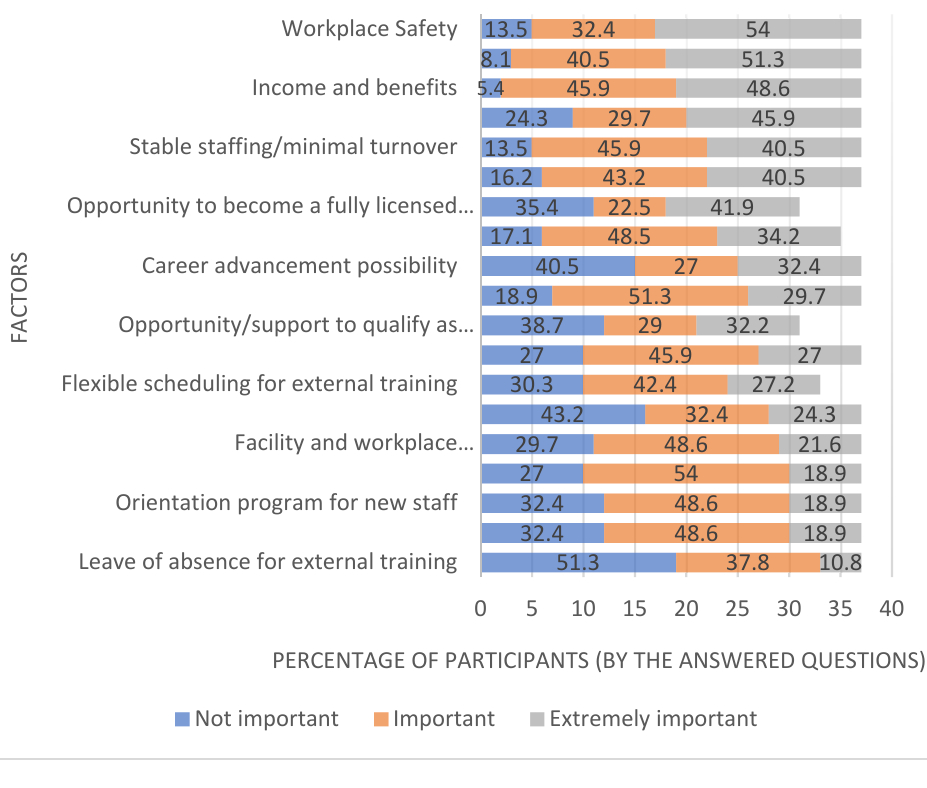
Figure 1. Importance of the factors that keep participants working at their current position in their current workplace.